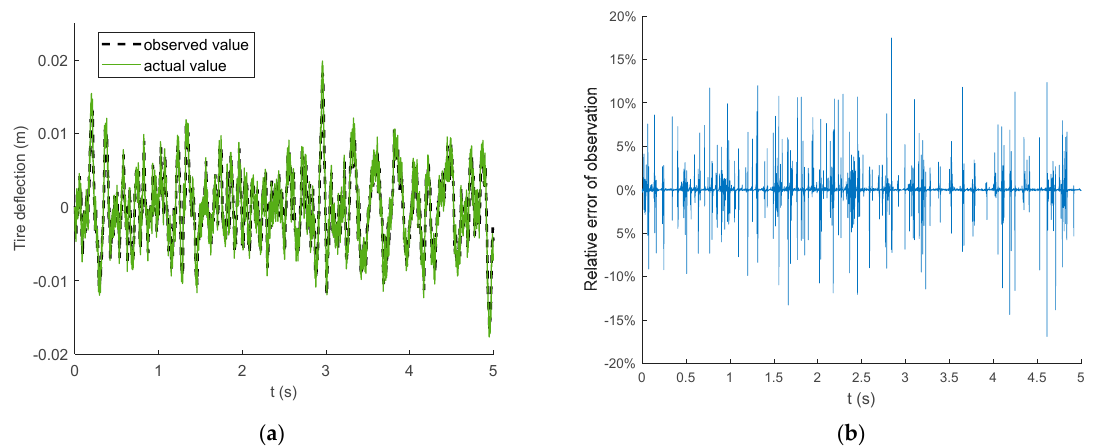
Figure 16. Observed results of tire deflection. ( a ) Comparison of observed and actual values. ( b ) Relative error between observed and actual values.